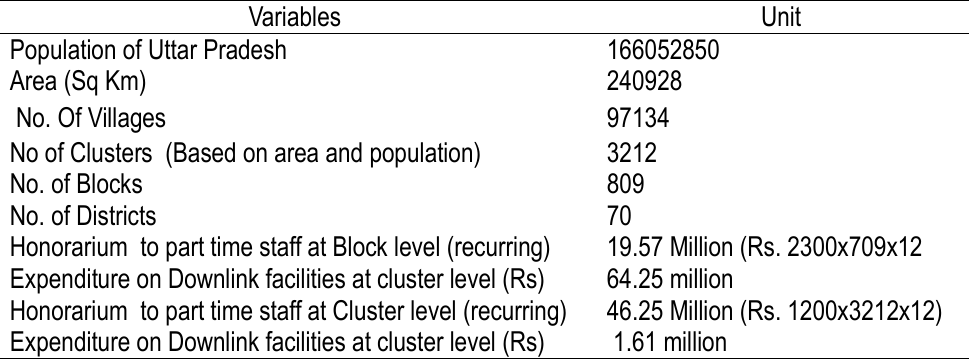
Table: Basic indicators and cost estimates on various items